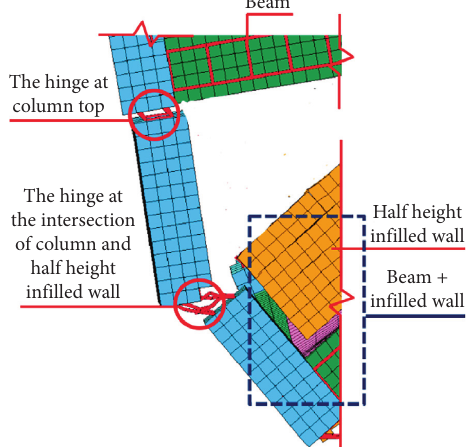
Figure 53: Failure state of second-floor side column.